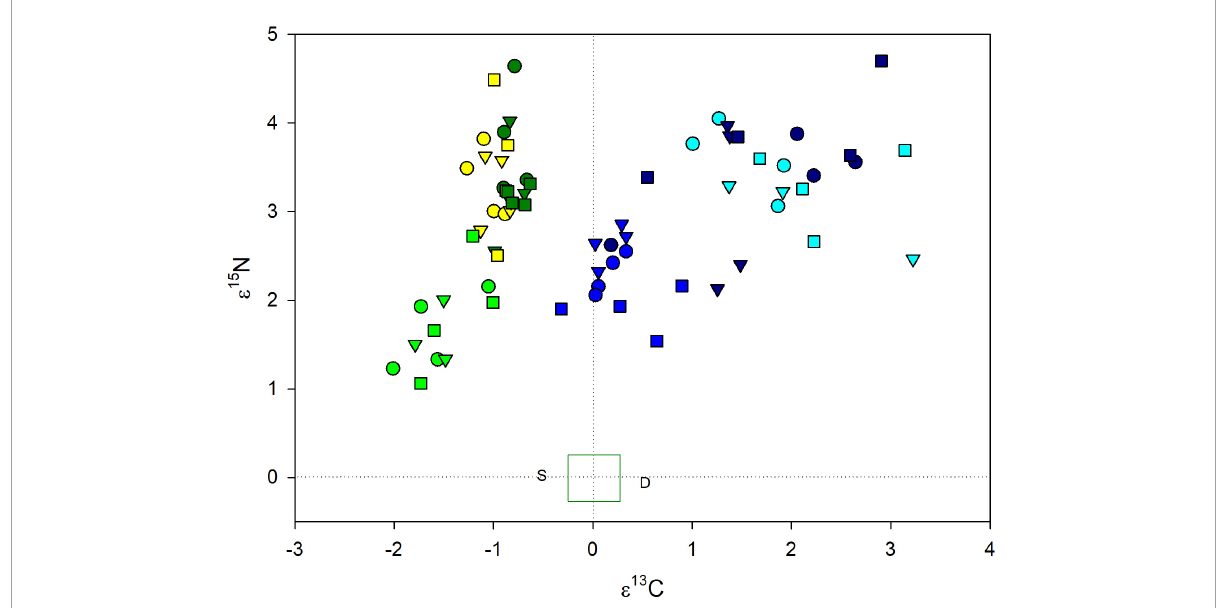
FIGURE2 Isotopic enrichment factors for 13 C and 15 N orchids ( G. pubescens : shades of green/yellow) and ( T. discolor : shades of blue) exposed to control (medium green or blue), drought (yellow or light blue), and shade (dark green or dark blue) treatments. Within each species, values for orchids from the three sites are presented as different symbols, though overlapping symbol shapes for the two species do not indicate shared sites. The green box around 0,0 indicates the mean (defined as 0) and standard error of enrichment factors for autotrophic reference plants ( Fagus grandifolia ). The isotopic enrichment factors for the single surviving shaded and drought-treated F. grandifolia are indicated as S and D,